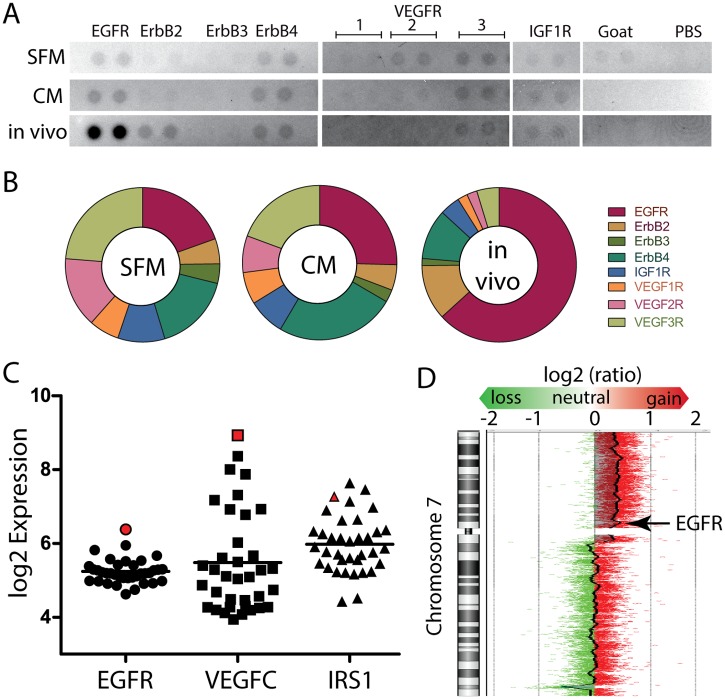
Potential targets of novel therapies.(A) Receptor tyrosine kinase (RTK) dot blot array. Goat IgG and phosphate buffered saline (PBS) are background controls. Each RTK is blotted in duplicate. (B) The proportion of signal contributed by select RTKs in serum free media (SFM), complete media (CM), and in tissues harvested after engraftment in a mouse (in vivo). (C) Microarray analysis for expression of EGFR, VEGFC, and IRS1 in model PH003 (red shape) and 35 other ovarian patient-derived tumorgraft models (black shapes). (D) Array comparative genomic hybridization showing chromosome 7. Red dots represent probes from the tumor genome and Green dots represent probes from the patient’s germline DNA. A balance of Red and Green probes signifies equal representation of tumor and germline DNA in the q arm. The p arm shows an unbalanced representation of tumor genomic DNA (log2 ratio 0.399 compared to germline). The bold vertical jagged line shows the average log2 ratio of tumor and germline DNA along chromosome 7.